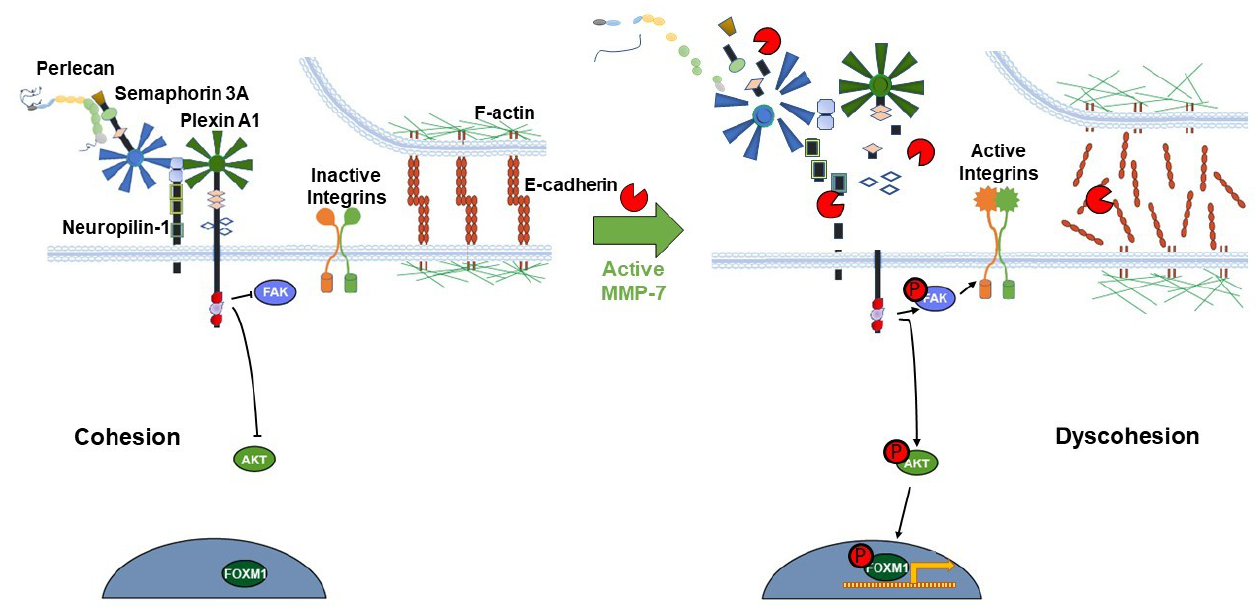
Figure 7. Proposed model of the PSPN Complex and E-cadherin/F-actin interaction in cohesive vs. dyscohesive PCa clusters. Model of the dynamic interactions between the PSPN Complex, MMP-7, and E-cadherin/F-actin. Perlecan and Sema3A secreted by the PCa surrounding stroma bind to and silence signaling from the plexin A1-NRP1 proteins. When unproteolyzed, this prevents activation of downstream FAK, AKT, and FOXM1, preventing dyscohesion. At this point, E-cadherin homodimers are intact and the cortical F-actin cytoskeleton is organized near the cell surface. Upon activation of MMP-7, cleavage of the PSPN Complex and extracellular E-cadherin ectodomain occurs, activating integrins, and releasing PCa cells to initiate dyscohesion and migration. Colors and shapes of the PSPN Complex components are described in Figure